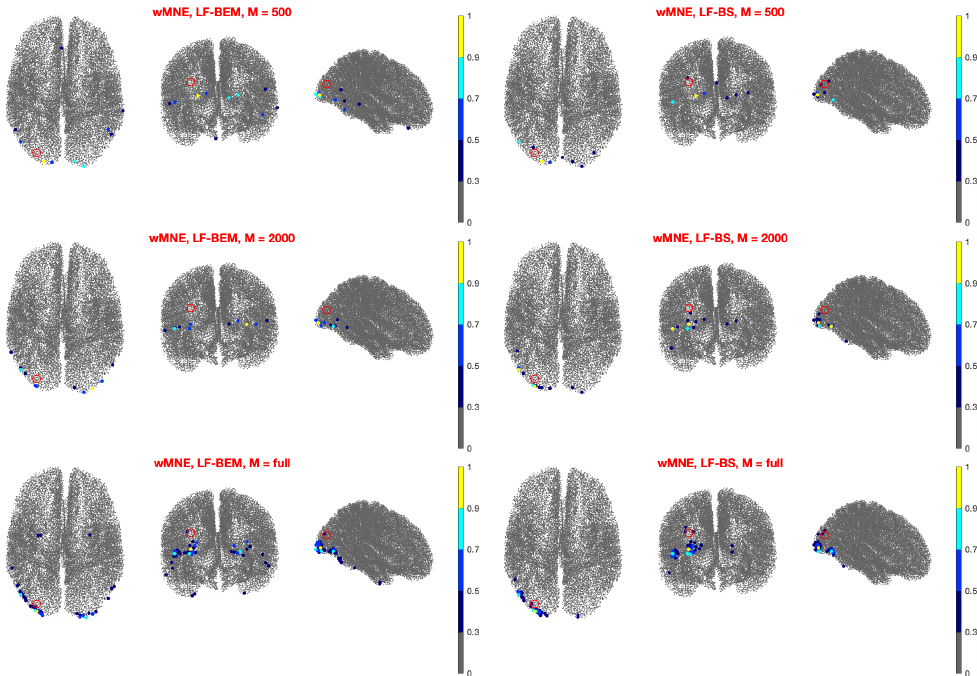
Figure 12. Right Visual evoked field: The intensity of the estimated sources, averaged over N = 10 runs, at 90 ms obtained using wMNE with M = 500 random points (first row), M = 2000 (second row) and the full source space (third row) for LF-BEM (left column) and LF-BS (right column). The red circle represents the dipole fitted using MNE.